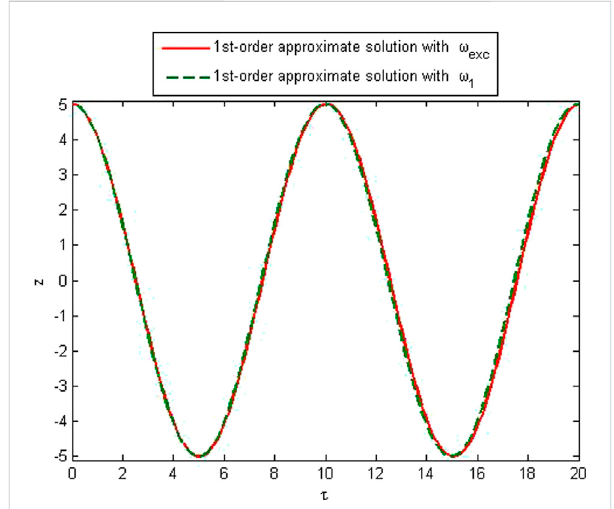
FIGURE 1 Illustration of the fi rst-order approximate solution with A (cid:2) 1.